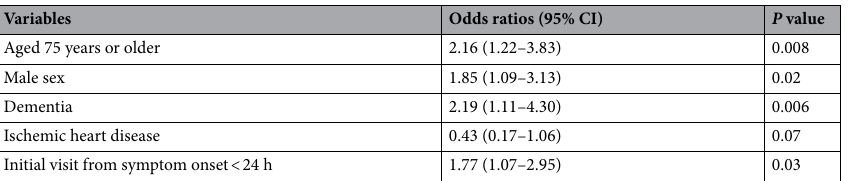
Table 3. Results of the multivariable analysis a for factors associated with no urinary symptoms or signs at presentation among patients with bacteremic urinary tract infections. a Variables were removed one-by-one using a backward stepwise method until all remaining variables had a p value of less than 0.2. The following variables were considered: age, sex, hypertension, dementia, stroke, ischemic heart disease, benign prostatic hypertrophy, diabetes, and time to initial visit from symptom onset. The level of statistical significance was set at 5% CI, confidence